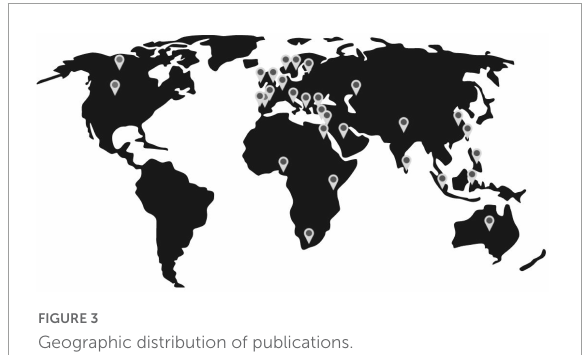
FIGURE3 Geographic distribution of publications.